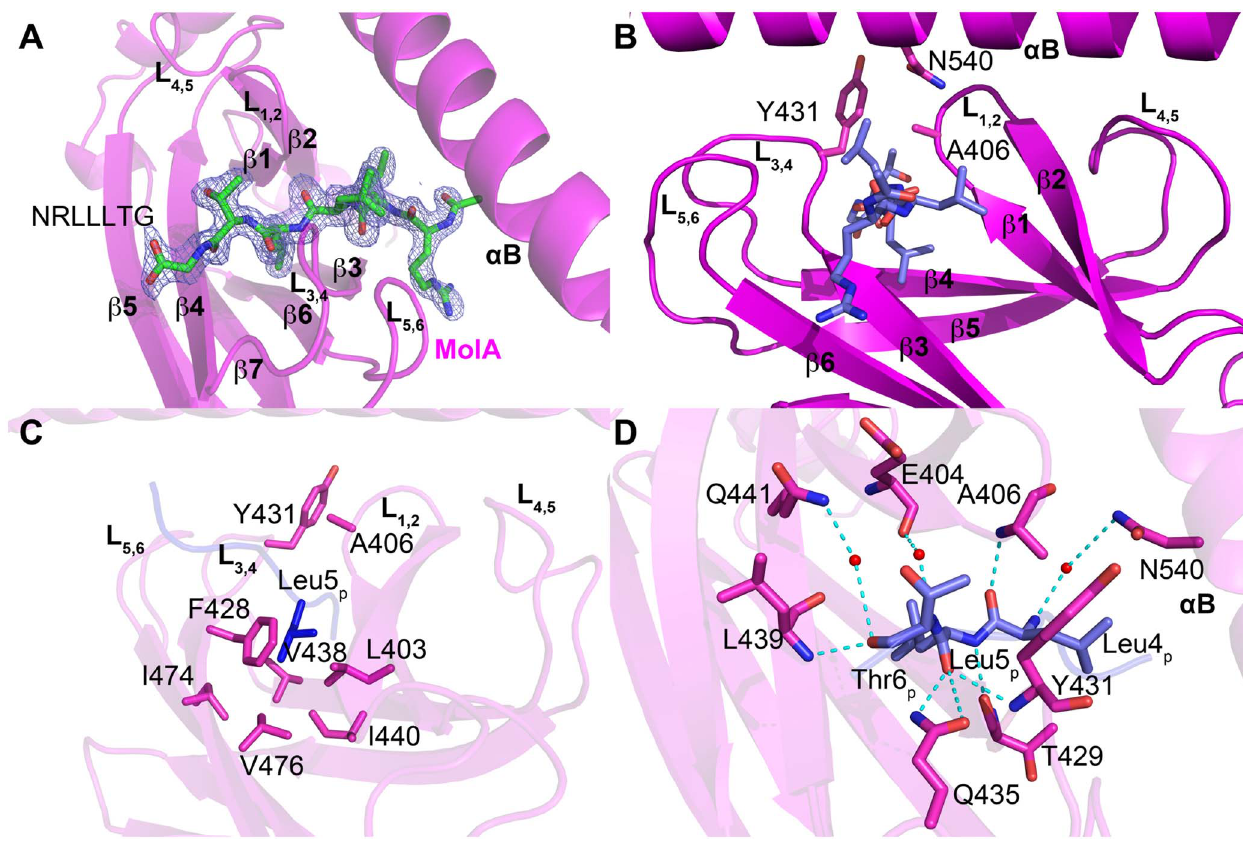
Figure 4. NRLLLTG peptide substrate binding by HSP70. A. Omit electron density of the peptide substrate bound to the b subdomain of molecule A is contoured at 3.0 sigma. The NRLLLTG peptide is shown as a stick model in CPK coloring. B. Peptide binding site highlighting the flanking L 1,2 and L 3,4, and supporting L 5,6 and L 4,5 loops. The NRLLLTG peptide and arch residues are shown as stick models. C. Detailed view of the NRLLLTG-binding pocket in HSP70-NRLLLTG highlighting a network of van der Waals contacts with Leu5 p of the NRLLLTG peptide. D. A close-up view of the interactions between Leu4 p -Leu5 p -Thr6 p of the NRLLLTG peptide and the surrounding residues in HSP70-NRLLLTG. All interacting residues are shown as sticks and hydrogen bonds are shown as dotted